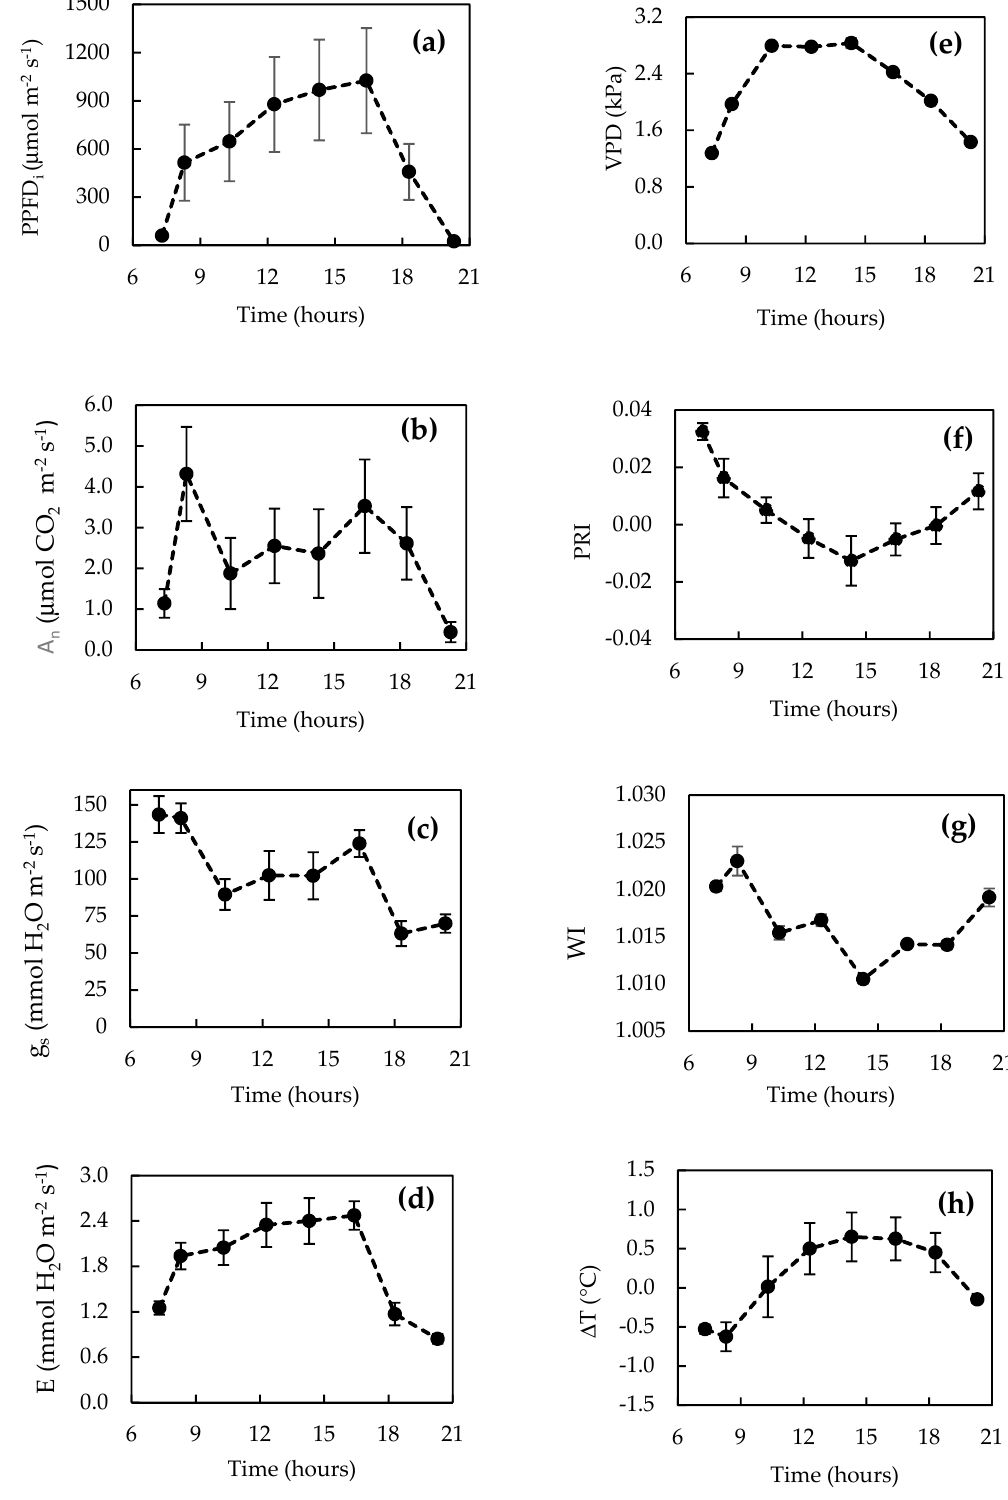
Figure 1. Diurnal time course of ( a ) photosynthetic photon flux density incident on the leaf (PPFDi), ( b ) net photosynthesis (A n ), ( c ) stomatal conductance (g s ), ( d ) transpiration rate (E), ( e ) leaf-to-air vapor pressure deficit (VPD), ( f ) photochemical reflectance index (PRI), ( g ) water index (WI), and ( h ) leaf-to-air temperature difference ( Δ T). Values are means ± standard errors of the mean ( n = 8).